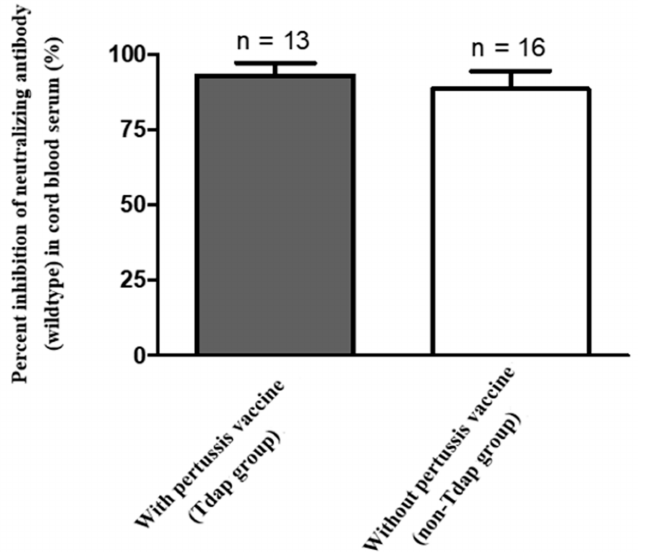
Figure 3. Mean percent inhibition of neutralizing antibodies (wildtype) in cord blood ( n = 29, p value =